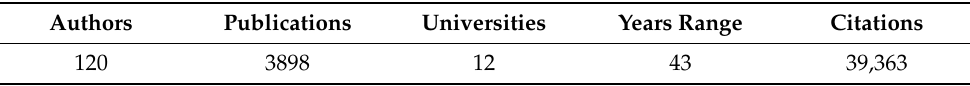
Table 3. Statistics of the collected